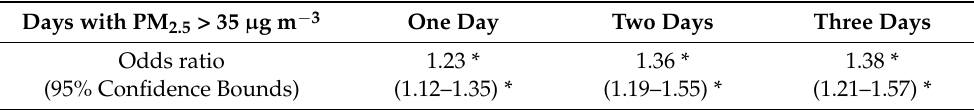
Table 2. Estimated odds ratio of at least one asthma emergency room visit as a function of number of days with PM 2.5 values greater than 35 in the previous week, evaluated via Equation (1).